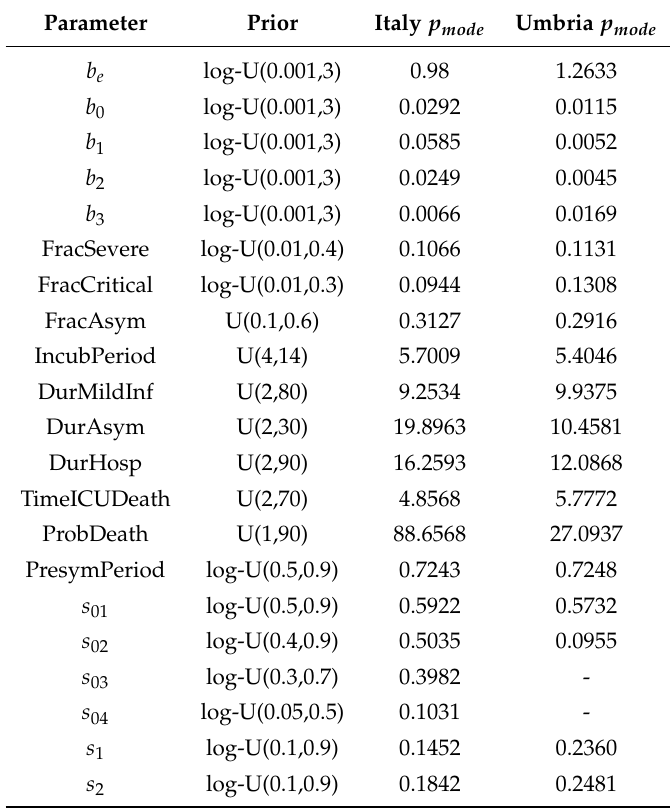
Table 1. Conditional Robust Calibration (CRC) results for Italy and Umbria. The second column shows the initial prior distribution of parameters. The initial range of transmission rates is taken from [10]. The fourth and fifth columns show, respectively, the mode vector of f P | P 10 final realizations for Italy and Umbria. In order to avoid integration errors, we suppose that the presymptomatic period (PresymPeriod) is a percentage of the incubation period